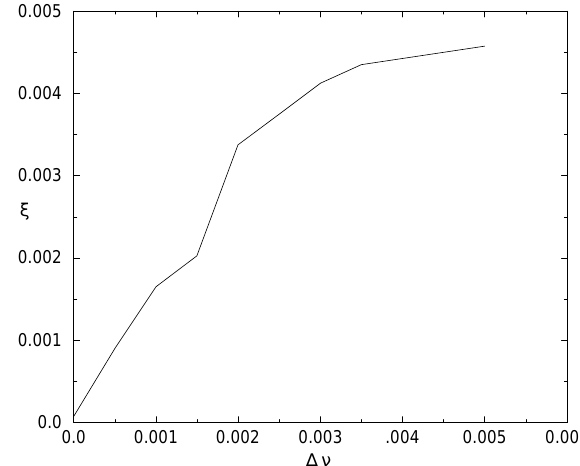
FIG. 14. Threshold antiproton tune shift j e (vertical axis) due to the electron beam vs the difference of antiproton horizontal and vertical tunes Dn (cid:1) n x 2 n y . B (cid:1) 10 kG, n s (cid:1) 0.001 , N ¯ p (cid:1) 6 3 10 10